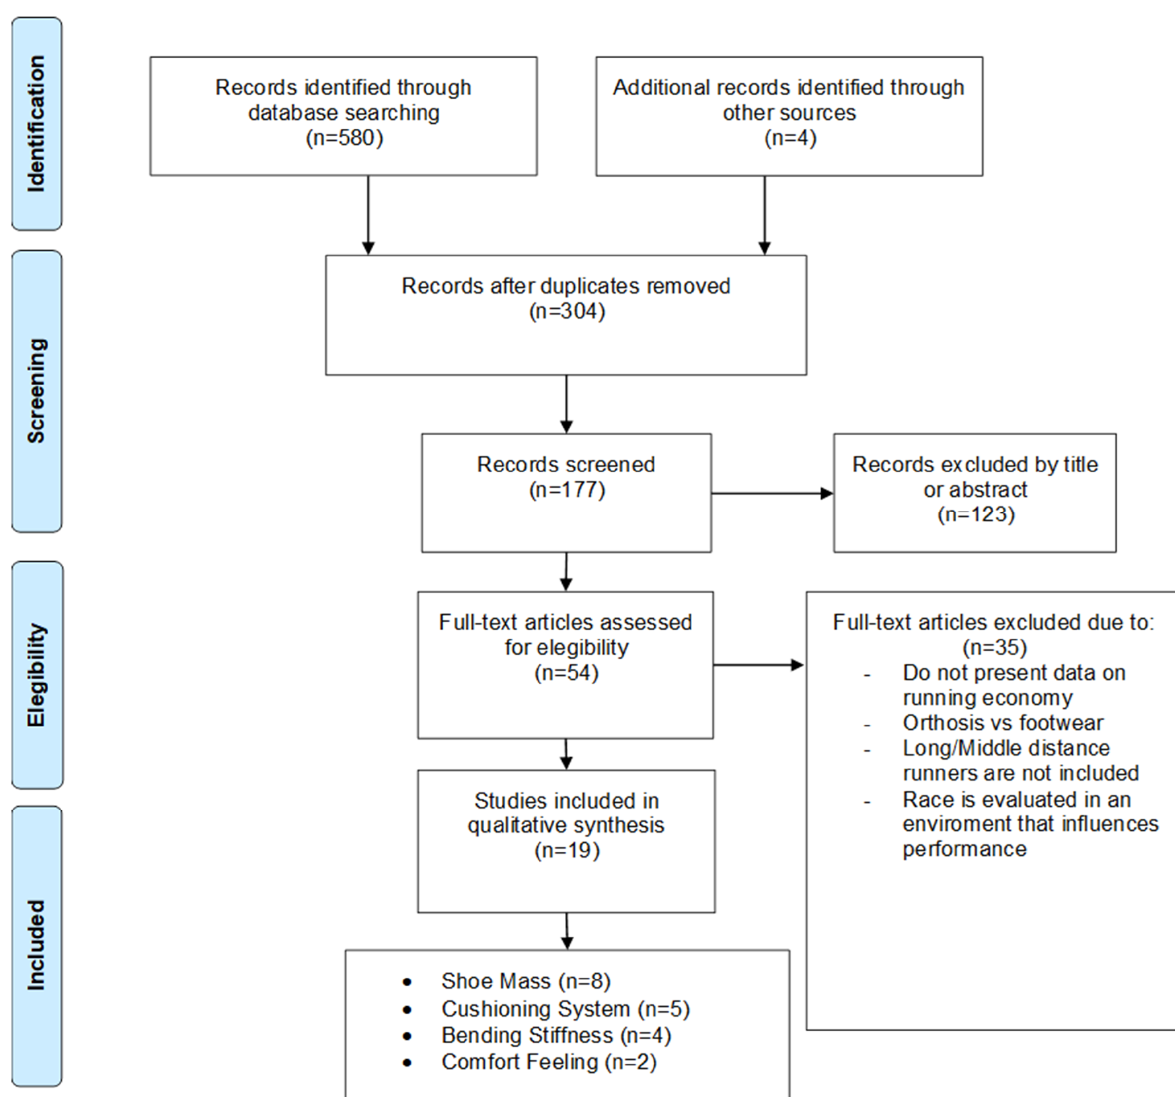
Figure 1. Flow diagram of the narrative review.